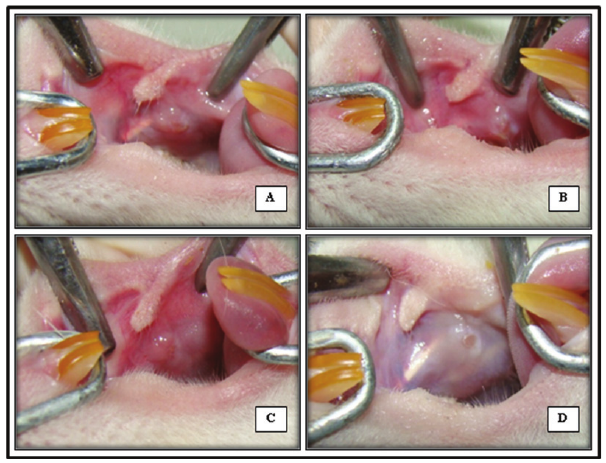
FIGURE 2 - Clinical aspect of the traumatic ulcers in the left cheek mucosa five ( A ), six ( B ), seven ( C ) and eight days ( D ) after the induction of the trauma with a nº 15 scalpel blade.